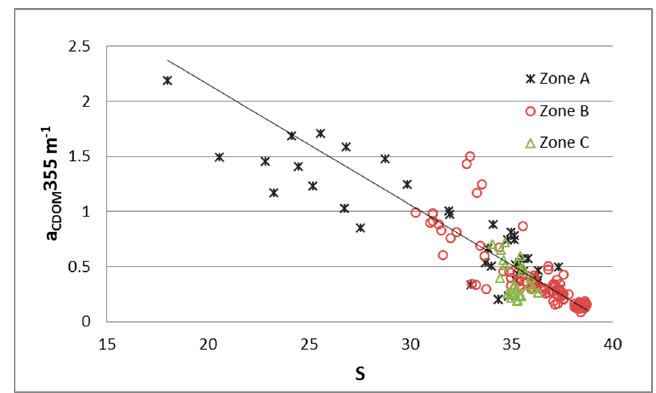
Figure 3. Relationship between a CDOM 355 and salinity (S) from in situ observations. The symbols represents the three areas of the Western Adriatic Sea, see text. The solid line is a regression line.